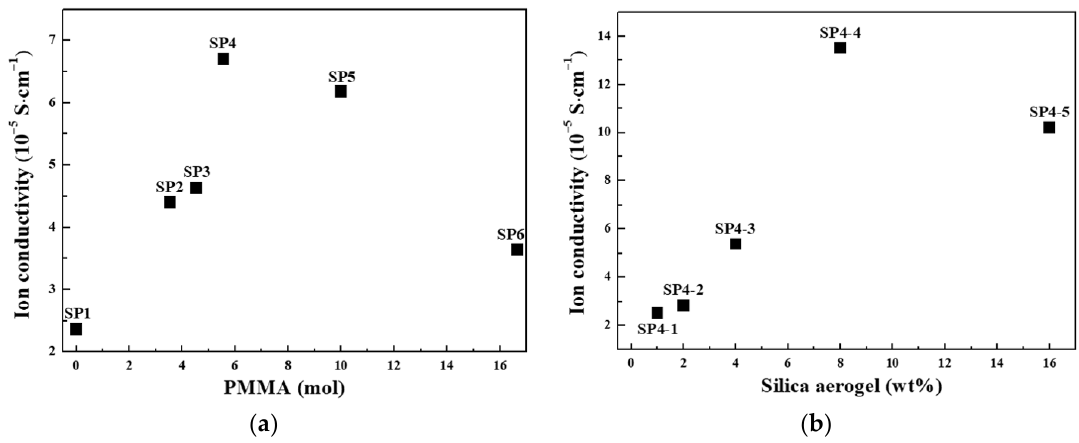
Figure 5. Lithium-ion conductivity of solid polymer electrolyte samples as a function of PMMA ( a ) and silica aerogel ( b ) content.